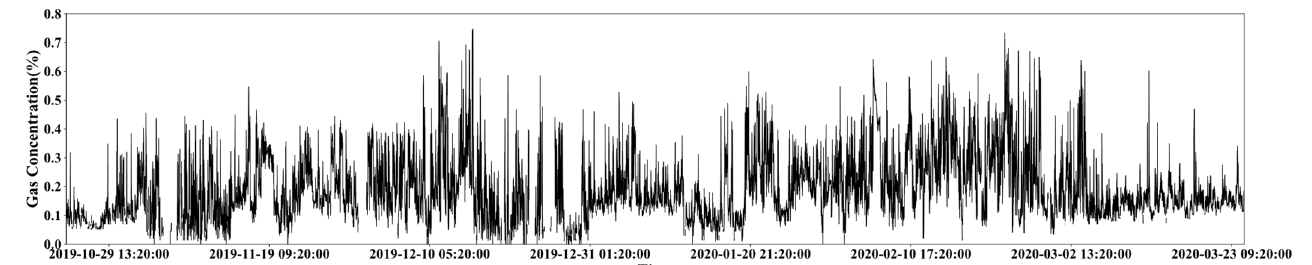
Figure A2. Variation trend of gas concentration in D3 data set.